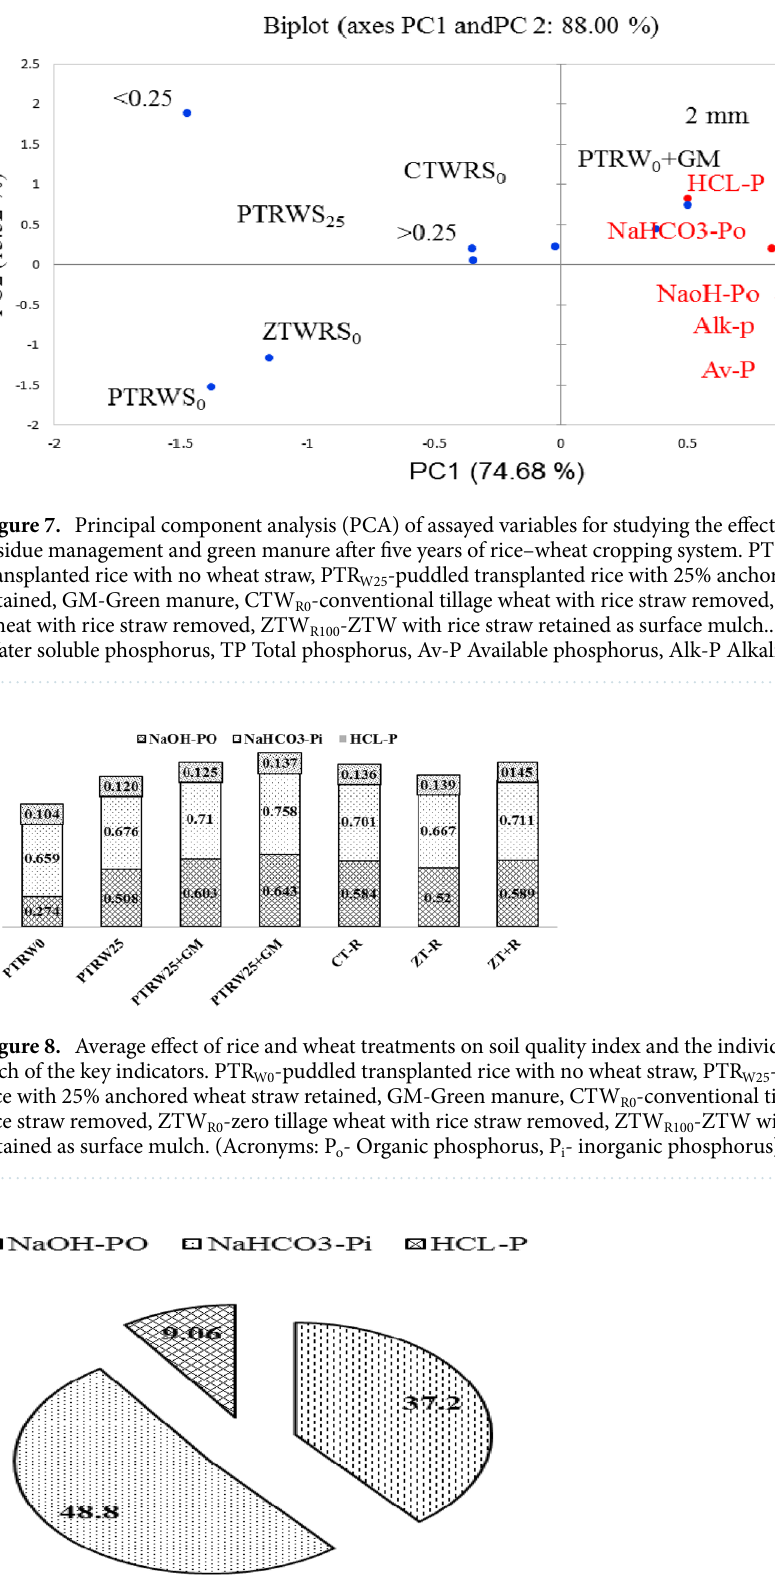
Figure 9. Overall contribution of the selected soil quality indicators to soil quality